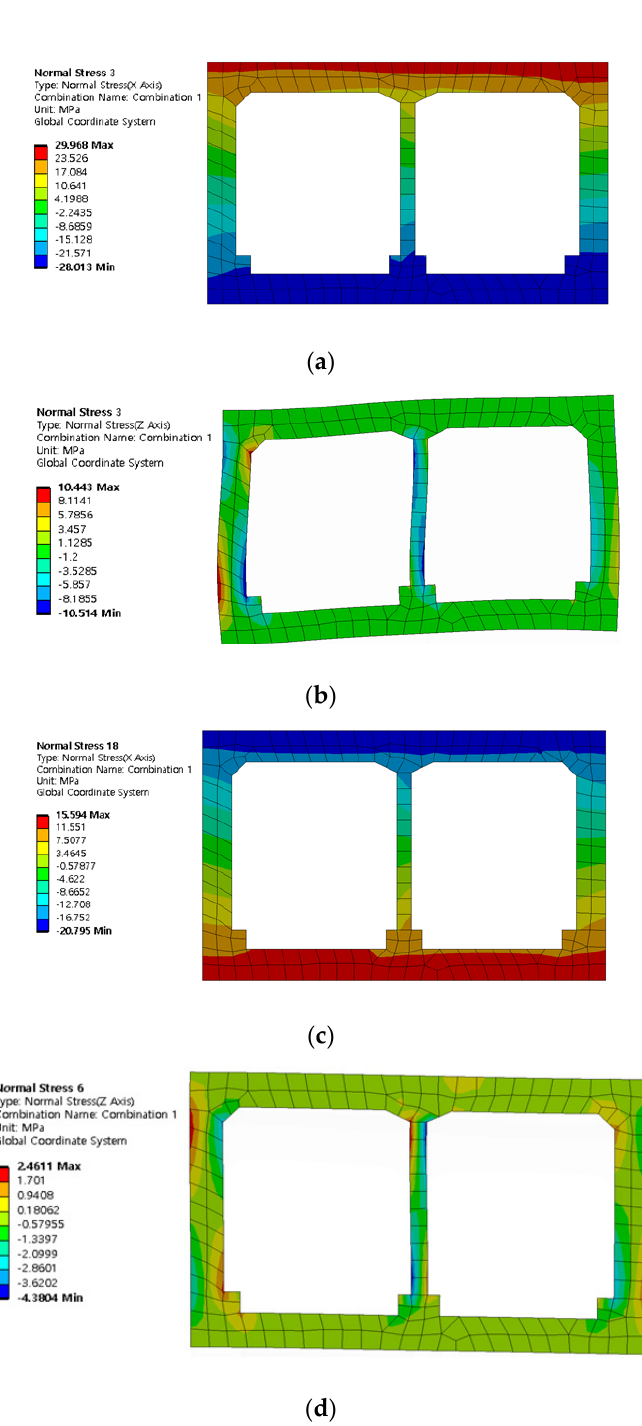
Figure 8. Stress analysis results in the position of maximum heaving and settlement: ( a ) normal stress (x-axis) at maximum heaving point (30 m); ( b ) normal stress (z-axis) at maximum heaving point (30 m); ( c ) normal stress (x-axis) at maximum settlement point (70 m); ( d ) normal stress (z-axis) at maximum settlement point (70 m).